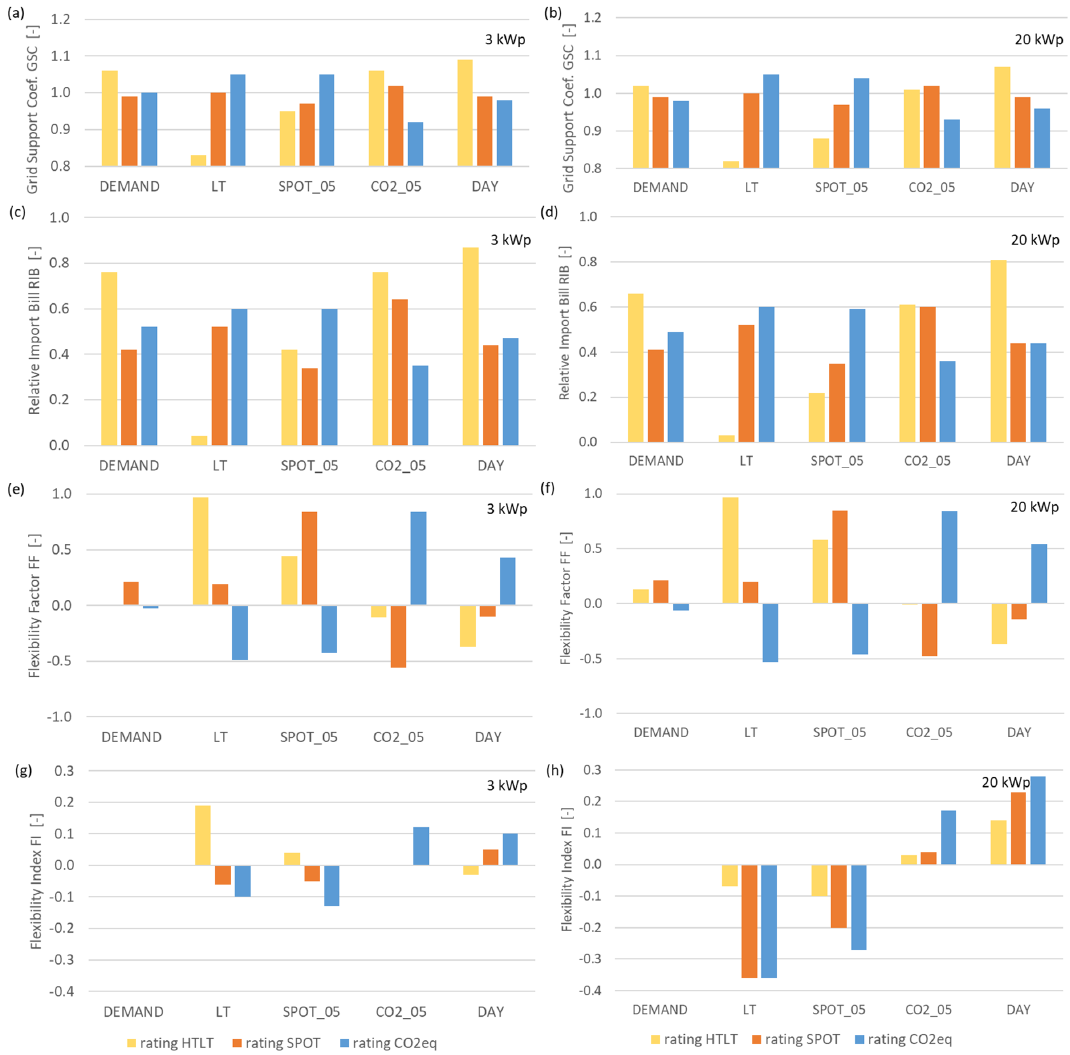
Figure 7. Flexibility factor GSC ( a , b ), RIB ( c , d ), FF ( e , f ) and FI ( g , h ) with self-consumption taken into account obtained with two photovoltaic systems (left: 3 kWp, right: 20 kWp [44]).